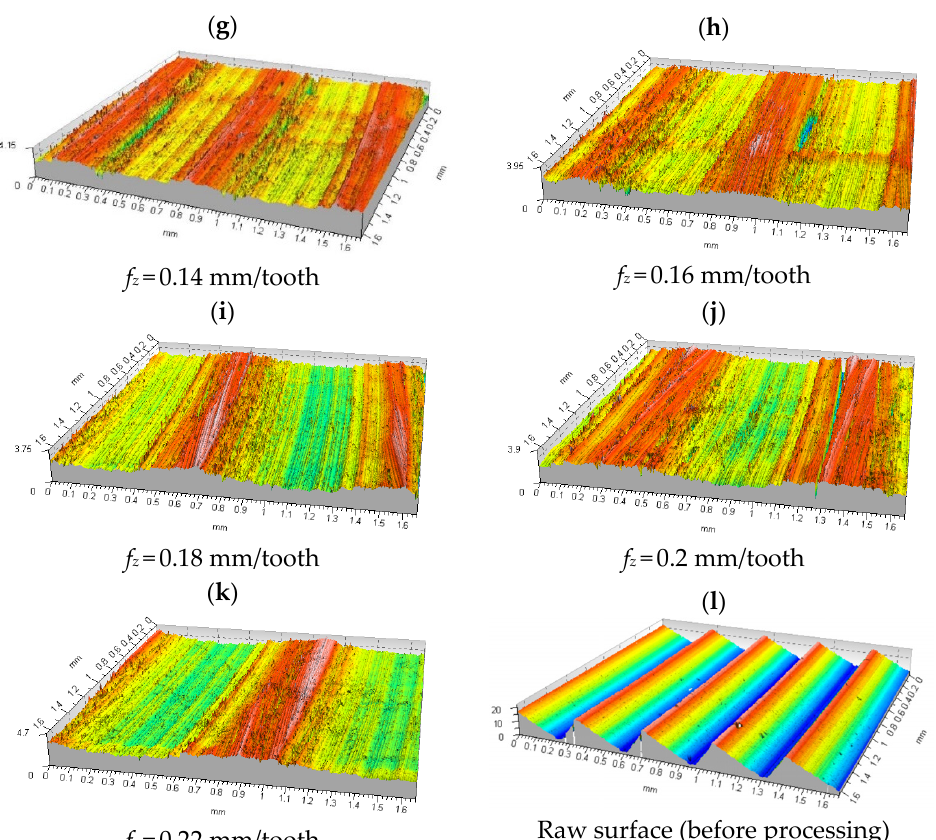
Figure 9. Summary of isometric images of the surface microgeometry of samples made of 2017A alloy machined with variable feed rate. Cutting parameters: v c = 300 m/min, n = 1911 rev./min, a p = 0.2 mm.